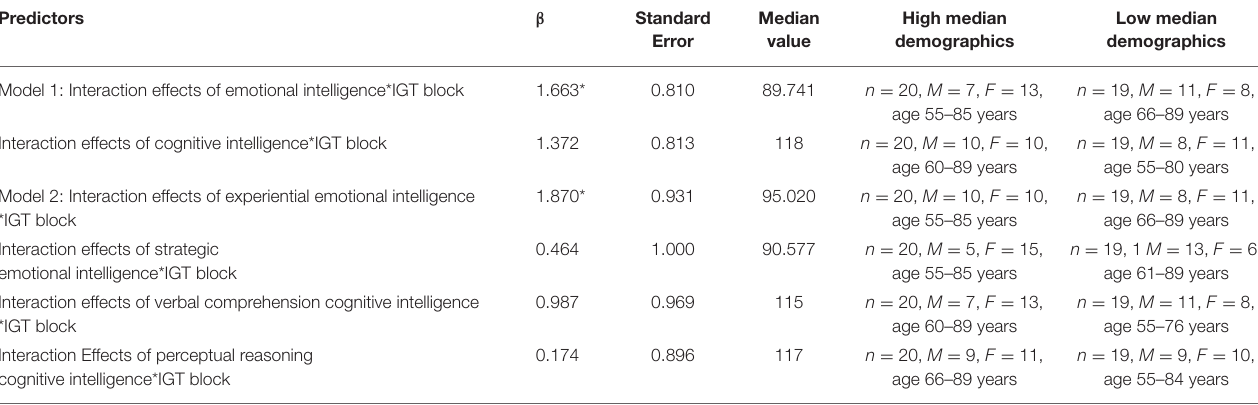
TABLE 3 | Significant results of hierarchical level models of intelligence and Iowa gambling task block performance.